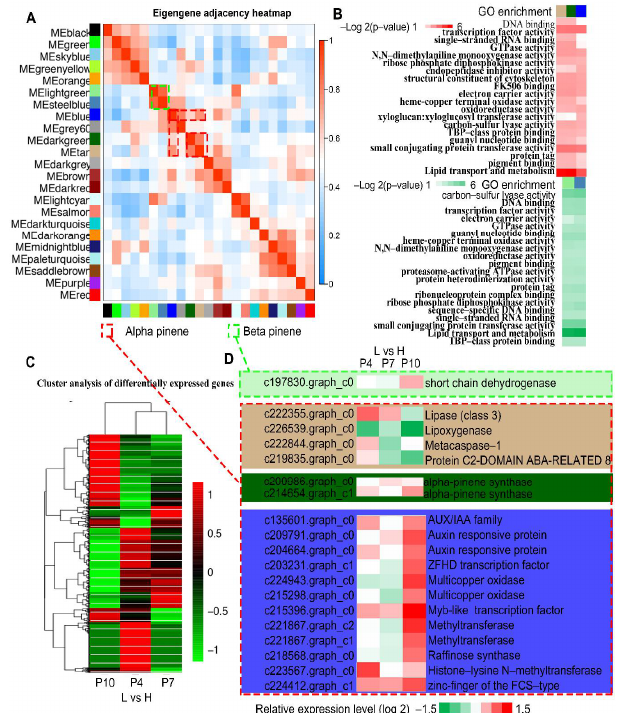
Figure 4. The DEGs associated with the biosynthetic and metabolic processes of α - and β -pinenes. ( A ) The eigengene adjacency heatmap of 23 modules. The dotted red or green frames represent co-expression modules associated with α - or β -pinenes contents, respectively. ( B ) GO enrichment analysis of genes in MEblue, MEdarkgreen, and MEtan modules associated with α -pinene, and MElightgreen, MEsteelblue associated with β -pinene. ( C ) Relative expression profiles of all genes in MEblue, MEdarkgreen, MEtan, MElightgreen, MEsteelblue modules. ( D ) Expression profiles of DEGs genes in MEblue, MEdarkgreen, MEtan, MElightgreen modules based on the RNA-seq